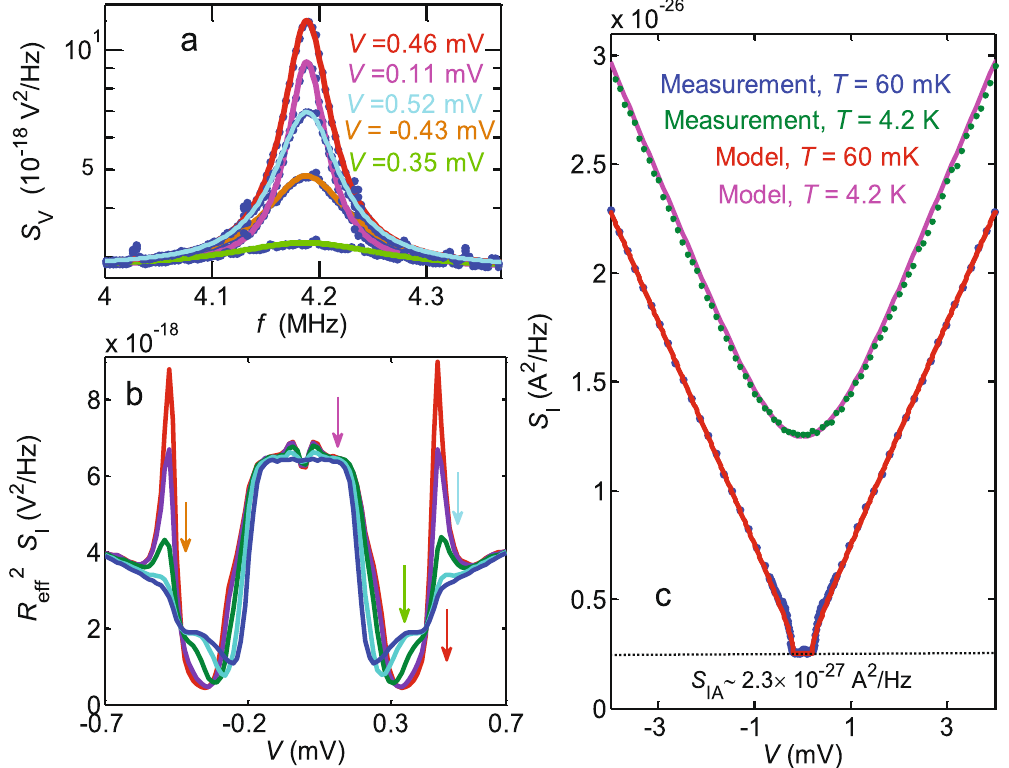
Figure 3. Noise measurements. (a) Power spectral density of the measured voltage noise at Φ = 0 for the indicated values of the bias voltage V (blue dots), plotted on a semilogarithmic scale. The solid lines are fits to Eq. 1. (b) Bias dependence of the peak height R S eff2 , extracted from fits to Eq. 1, for a few equally spaced values I of magnetic flux between Φ = 0 (red solid line) and Φ = 0.5 Φ 0 (blue solid line). (c) Total current noise S I vs. the DC bias, measured at T = 4.2 K with the junction in the normal state, and at T = 60 mK in the superconducting state, together with the theoretical predictions (see text for details). The dashed horizontal line indicates the background noise level, independent of V and Φ